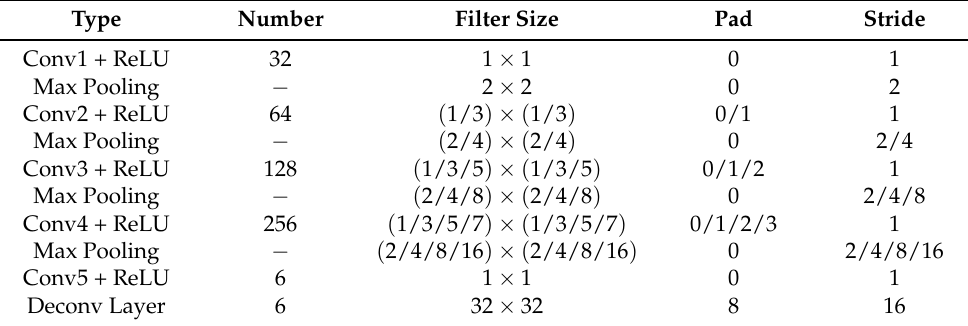
Figure 4. The figure compares standard convolutional kernels and deformable convolutional kernels. Since the feature map gradually becomes smaller during the convolution process, to obtain a feature map with the same size as the original image, we needed to upsample the feature map. An intuitive idea is to perform bilinear interpolation, which is easily imple- mented with a fixed kernel via deconvolution. Therefore, at the output of the mmsDCNN, we replaced the fully connected network of the mmsCNN model with a deconvolutional network. In addition, before deconvolution, we needed to fuse the multiscale features and then utilize a simple convolution to make the number of channels of the output feature map the same as the predetermined number of categories of the pixels. Notably, the output of the mmsDCNN model is a feature map of the same size as the input image, which will be further processed by DenseCRF to obtain the final prediction map. Table 1 shows the parameter settings of our mmsDCNN model. Table 1. Structure parameters of our mmsDCNN